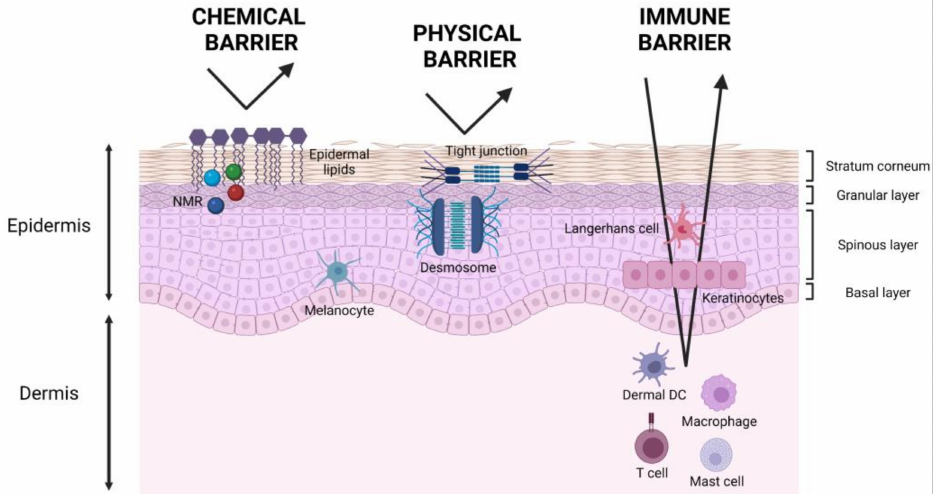
Figure 1. Schematic representation of skin barrier functions. The chemical barrier is mainly due to natural moisturizing factors (NMF) and epidermal lipids in the stratum corneum. The physical barrier is accomplished thanks to tight junctions and desmosomes in the granular and spinous layers. The immune barrier is carried on by skin-resident immune cells in the epidermis and dermis such as Langerhans cells and dermal dendritic cells, macrophages, resident T cells, and mast cells, respectively, and by epidermal